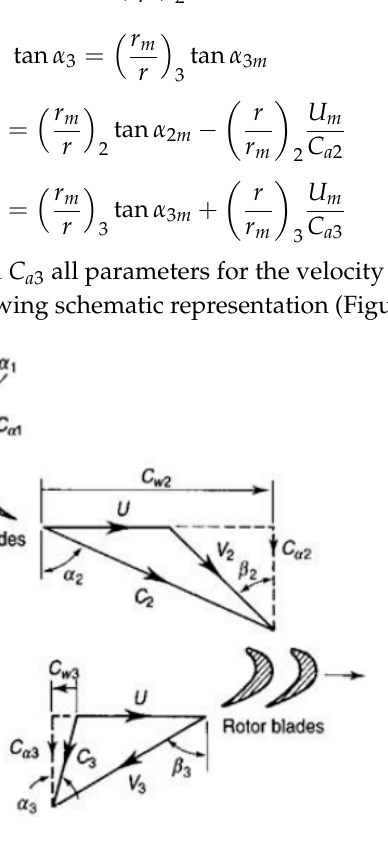
Figure 1. Velocity diagram of a turbine nozzle inlet and exit as well as as the turbine rotor exit [12].